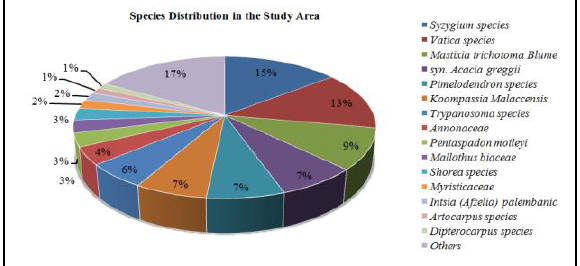
Figure 8. Species distribution in the study area